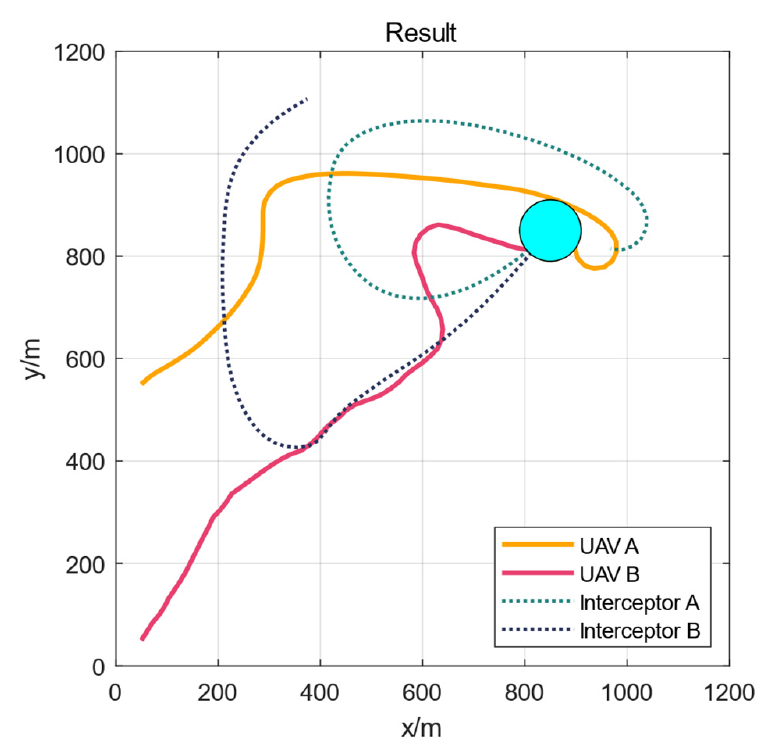
Figure 7. Experiment Result.